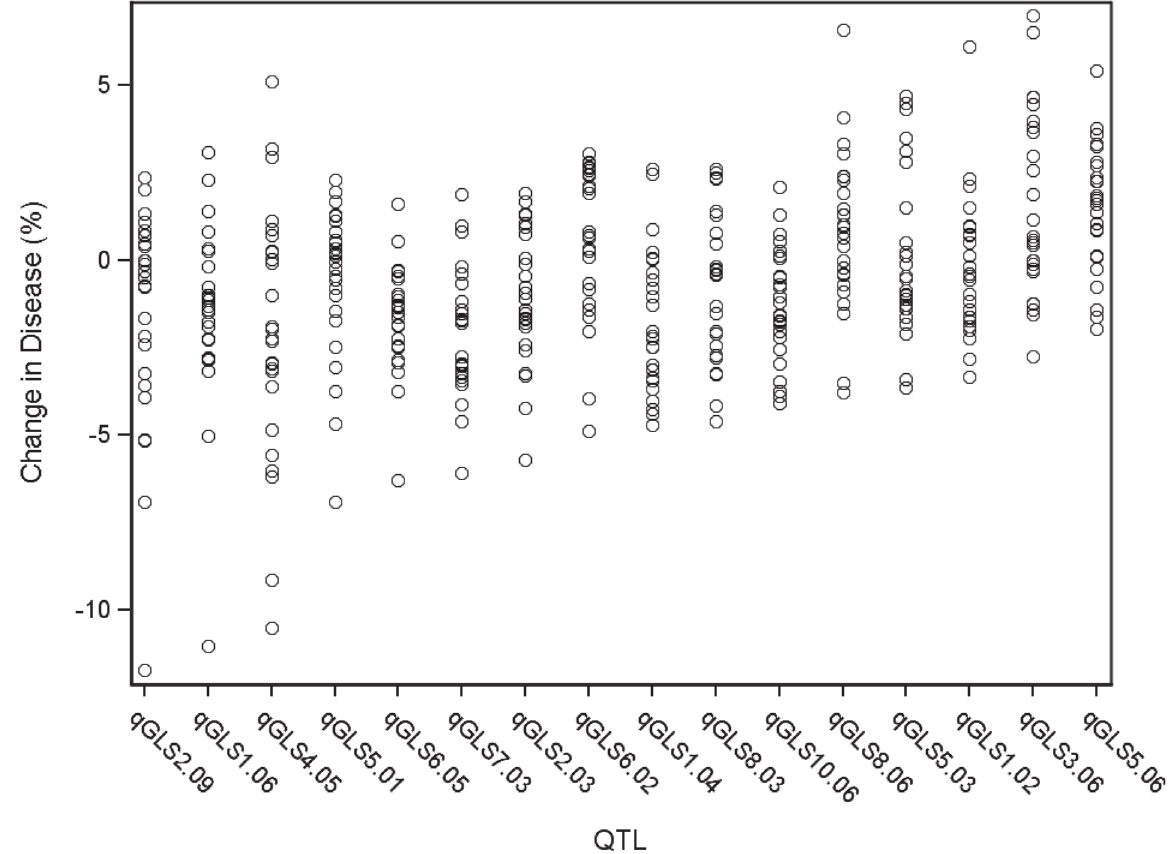
Fig 2. General linear model predicted percent change in disease across significant disease quantitative trait loci (QTL). Each circle indicates the predicted change in disease of a single allele. There are 26 circles for each QTL, each representating the allele from one of the nested association mapping parental